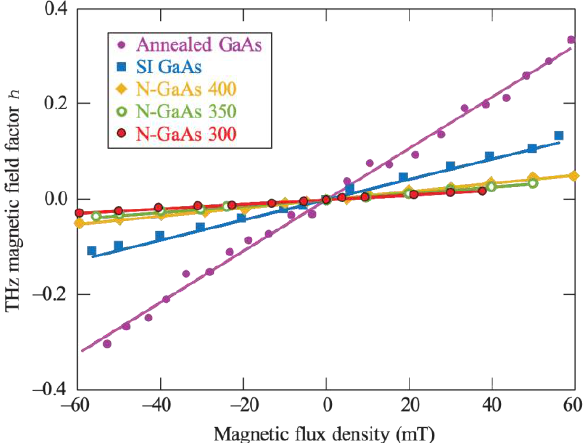
Figure 6. Magnetic-field factor 𝜂 of transient THz amplitudes vs. the magnetic flux density for all five GaAs samples used in the study. Dots are experimental datapoints collected from every sample (see the text) and solid lines are the corresponding best linear fits.